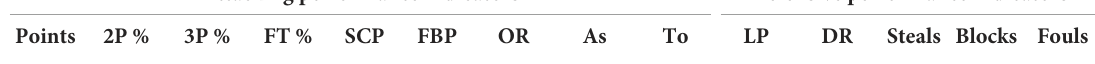
TABLE 4 The differences in the attacking and defensive performance indicators between the top eight and bottom eight teams. Attacking performance indicators Defensive performance indicators